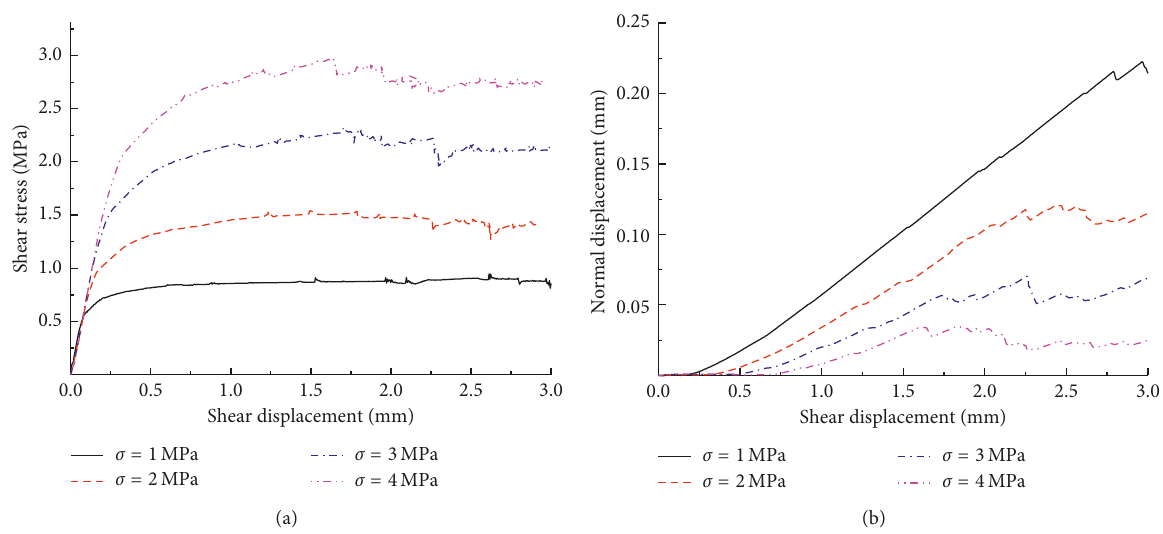
Figure 17: Results for a joint with a JRC of 10–12. Curves of (a) the shear stress and displacement and (b) the normal and shear displacement.